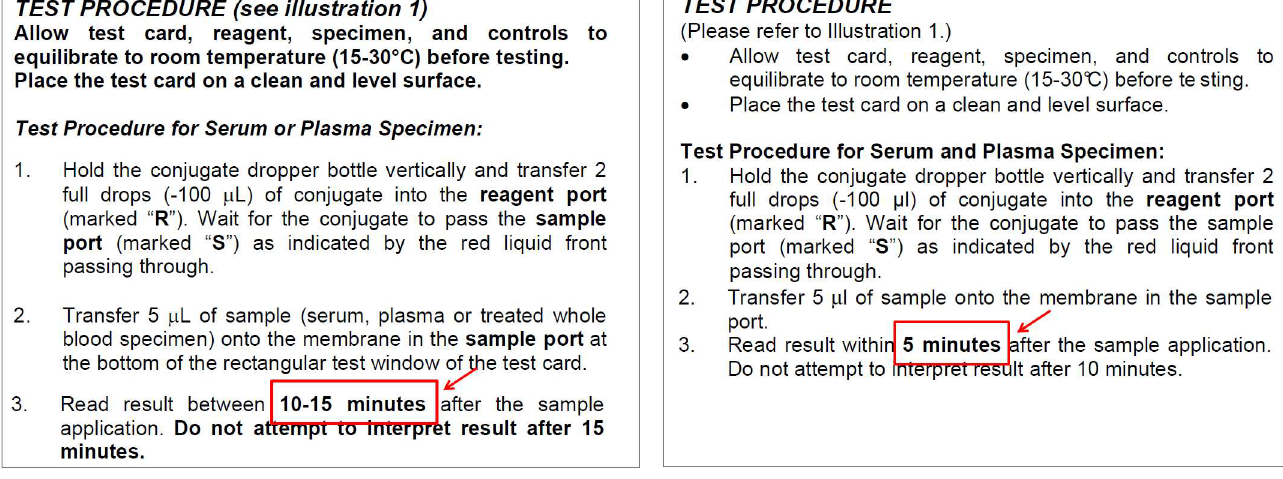
Fig 3. Two successive versions of the instructions for use of a rapid diagnostic test (most recent version on the right). The change in reading time (indicatedwith a red arrow on the picture) was not communicated to the user in writing, by an alert on the box, or through a new version number, “track changes,” or a revision history of the instructionsfor use. Only the date of issue of the instructionsfor use had